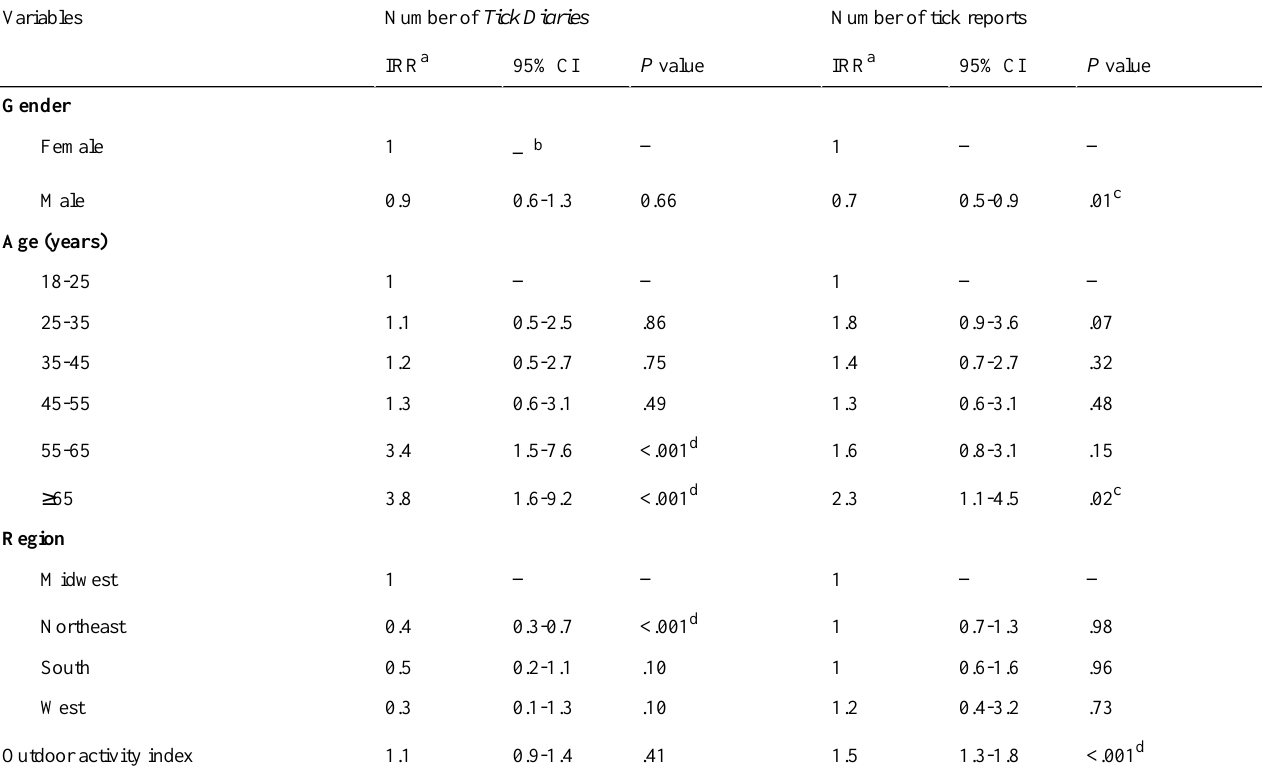
Table 4. Generalized linear model for the number of Tick Diaries and tick reports submitted per user versus demographic variables, location (region), and frequency of outdoor activities (outdoor activity index). We used a negative binomial model, and the effect of each independent variable is expressed as incidence rate ratios (N=712).